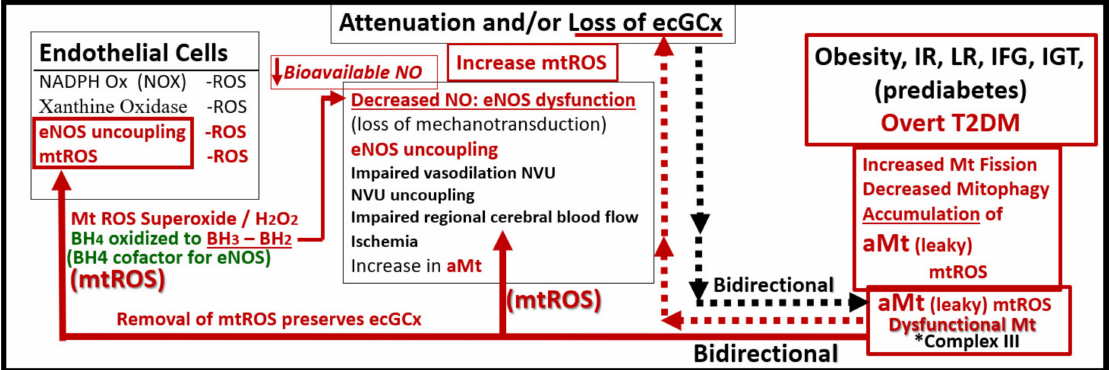
Figure 19. Emerging evidence may suggest a possibility for a bidirectional relationship between aberrant Mt (aMt) and the endothelial glycocalyx (ecGCx) dysfunction and/or loss in endothelial cells, including brain endothelial cell(s) (BECs) and possibly other organs in obesity, insulin resistance (IR), leptin resistance (LR), metabolic syndrome (MetS), and type 2 diabetes mellitus (T2DM). This figure illustrates that there may be a bidirectional relationship between aMt and dysfunction, attenuation, and/or loss (shedding) of the brain BECs ecGCx. Note that this illustration establishes the role of oxidant stress—reactive oxygen species (ROS) in BECs and specifically mitochondrial ROS (mtROS) (left-hand box). Further, it establishes the important role of the dysfunctional attenuated and/or loss of the ecGCx in the brain (center box). Next, it establishes that obesity, IR, LR, impaired fasting glucose (IFG), impaired glucose tolerance (IGT), and overt T2DM are related to increased Mt fission, decreased mitophagy, and the accumulation of leaky aMt that leak mtROS (right-hand box). Further, this image depicts that these leaky aMt may be responsible for the attenuation and/or loss of the ecGCx (red-dashed arrows) and that, in turn, may result in the loss of the ecGCx that may contribute to an increase in aMt (black-dashed arrows). Importantly, mtROS superoxide or H2O2 could oxidize the essential tetrahydrobiopterin (BH4) cofactor that is absolutely essential for the eNOS enzyme to produce nitric oxide (NO) and result in eNOS uncoupling, which would ultimately result in decreased bioavailable NO. This bidirectional interaction could result in a vicious cycle, which could be interrupted by preventing the accumulation of aMt (improved mitophagy) or preventing the dysfunction, attenuation, and/or loss (shedding) of the ecGCx [38,59–68]. The asterisk signifies emphasis of complex